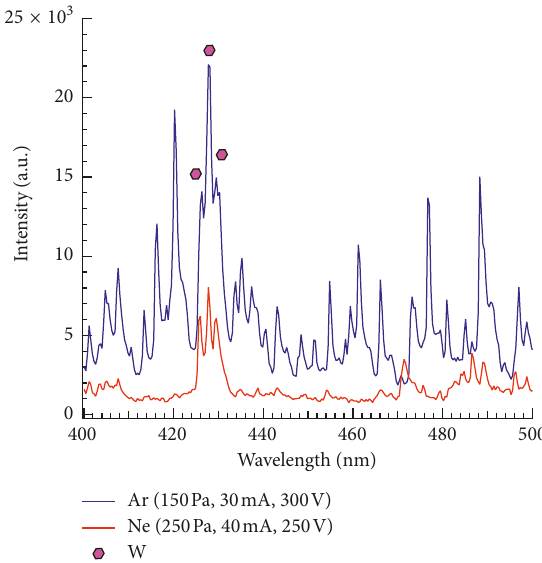
Figure 4: Tungsten hollow cathode emission